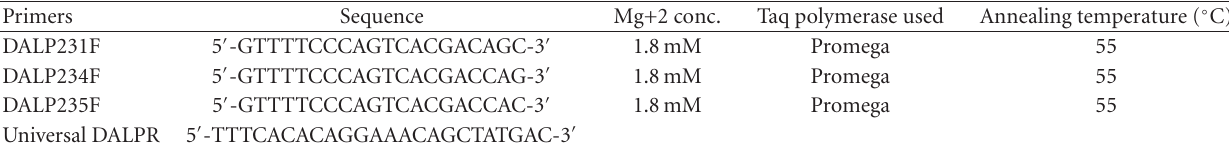
Table 2: Optimisation of DALP primers used for the PCR protocols. Primers Sequence Mg+2